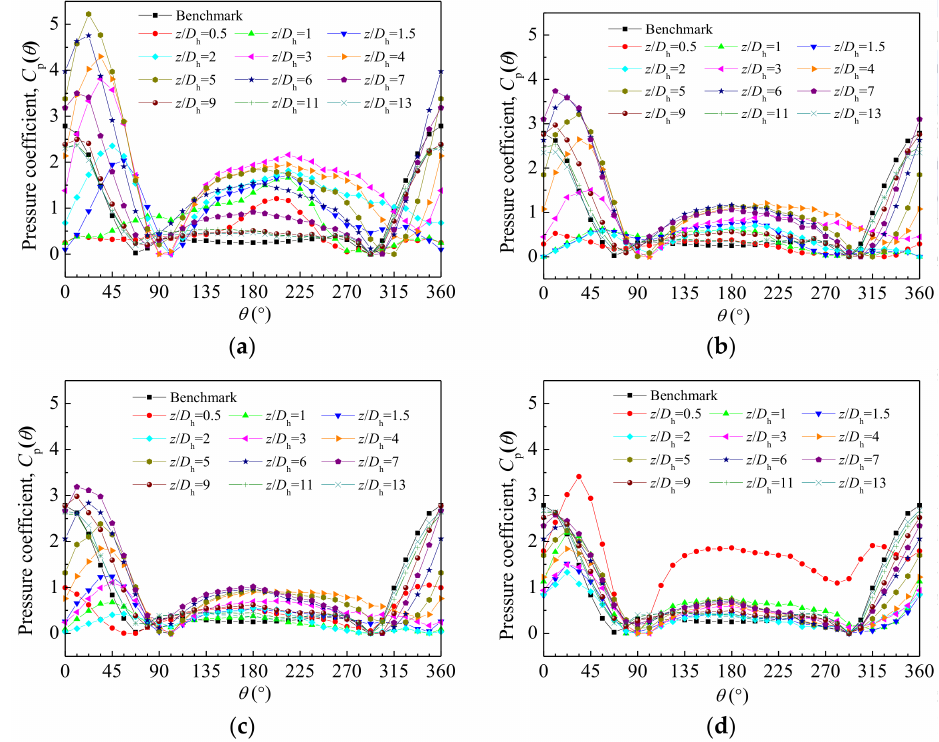
Figure 14. Pressure distributions at different positions with different angle of the vanes at R = 0.150: